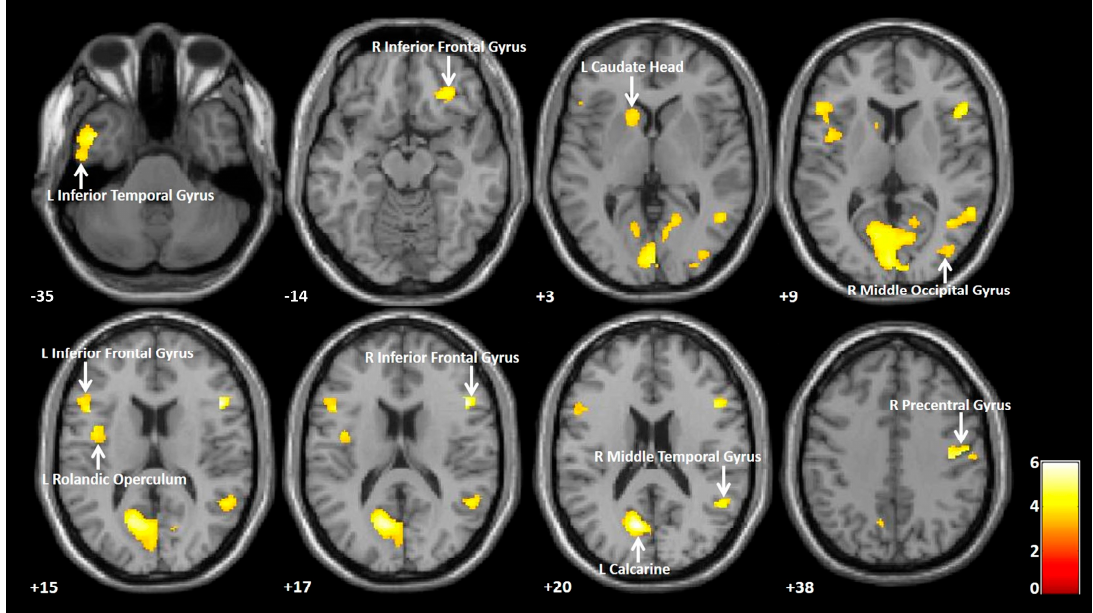
Figure 1. Lower gray matter volumes (GMVs) in PDD patients with fall vs without fall, with highlighted significant areas. Compared to PDD patients without fall, PDD patients with fall showed significantly lower GMV in the left inferior temporal gyrus, right inferior frontal gyrus, left caudate head, right middle occipital gyrus, left inferior frontal gyrus, left Rolandic operculum, right inferior frontal gyrus, right middle temporal gyrus, left calcarine, and right precentral gyrus. Among these areas, the clusters of left calcarine and R inferior frontal gyrus survived from statistical threshold of FWE-corrected p <